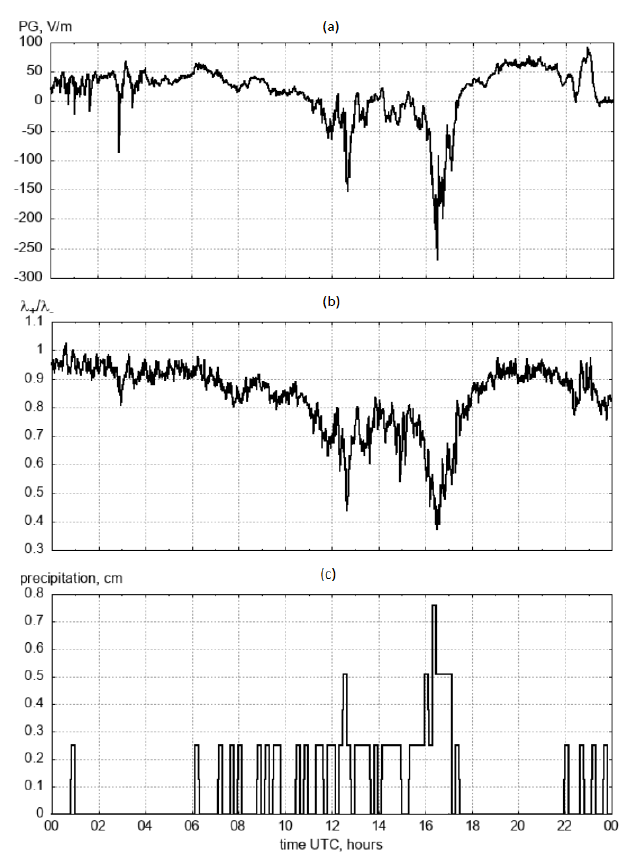
Figure 5. Rain effect for 8 August 2009: ( a ) PG values; ( b ) the value of unipolarity; ( c ) the precipita- tion level.